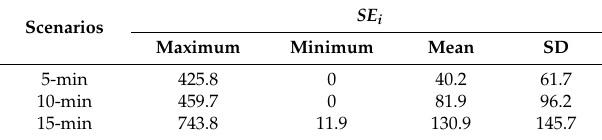
Figure 5. The geography of SE i in di ff erent integrated scenarios. ( a ) 5-min integrated scenario; ( b ) 10-min integrated scenario; ( c ) 15-min integrated scenario. Table 1. The descriptive statistical indicators of SE i in di ff erent scenarios.